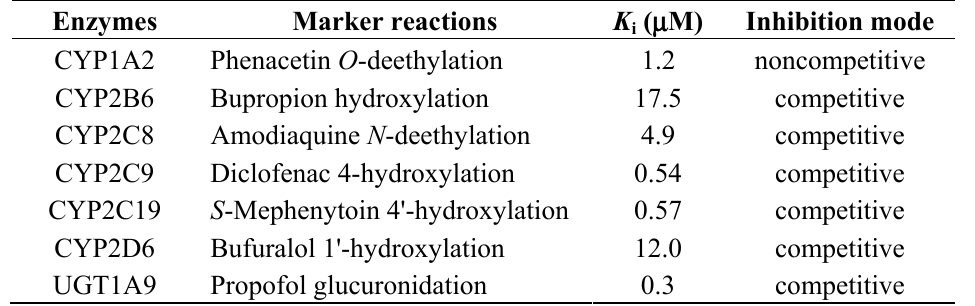
Table 2. K values for the inhibition of CYP1A2, CYP2B6, CYP2C8, CYP2C9, CYP2C19, i CYP2D6, and UGT1A9 activities by honokiol in pooled human liver microsomes (H161). Enzymes